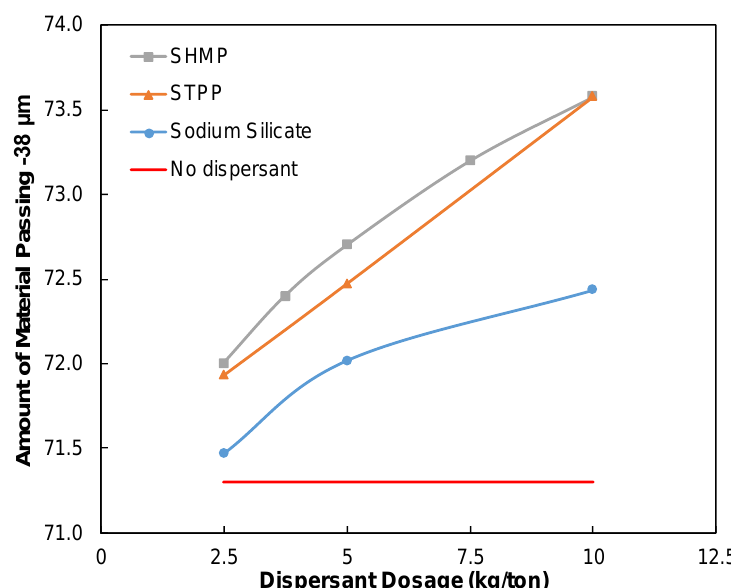
Figure 14. Change in the ratio of material passing to <38 µm size halloysite ore according to dispersant types and dosages (1000 rpm blunging speed and 35% pulp concentration at 25 °C room temperature and natural pH of 3.9).